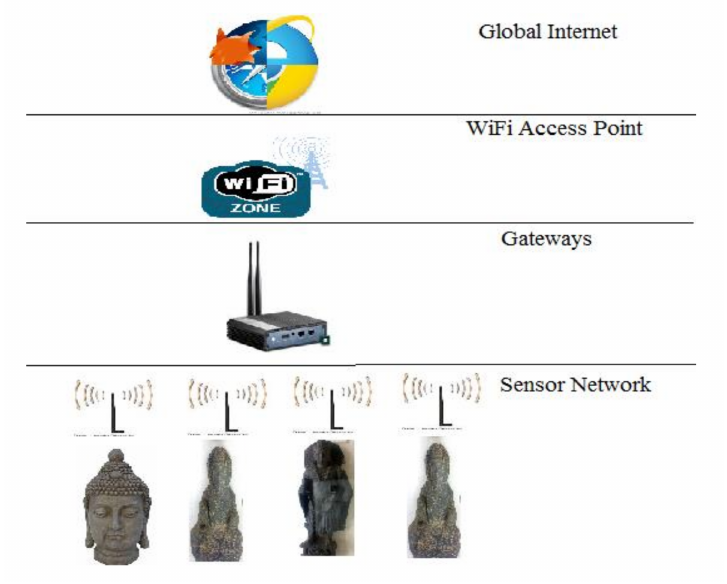
Figure 5. Network